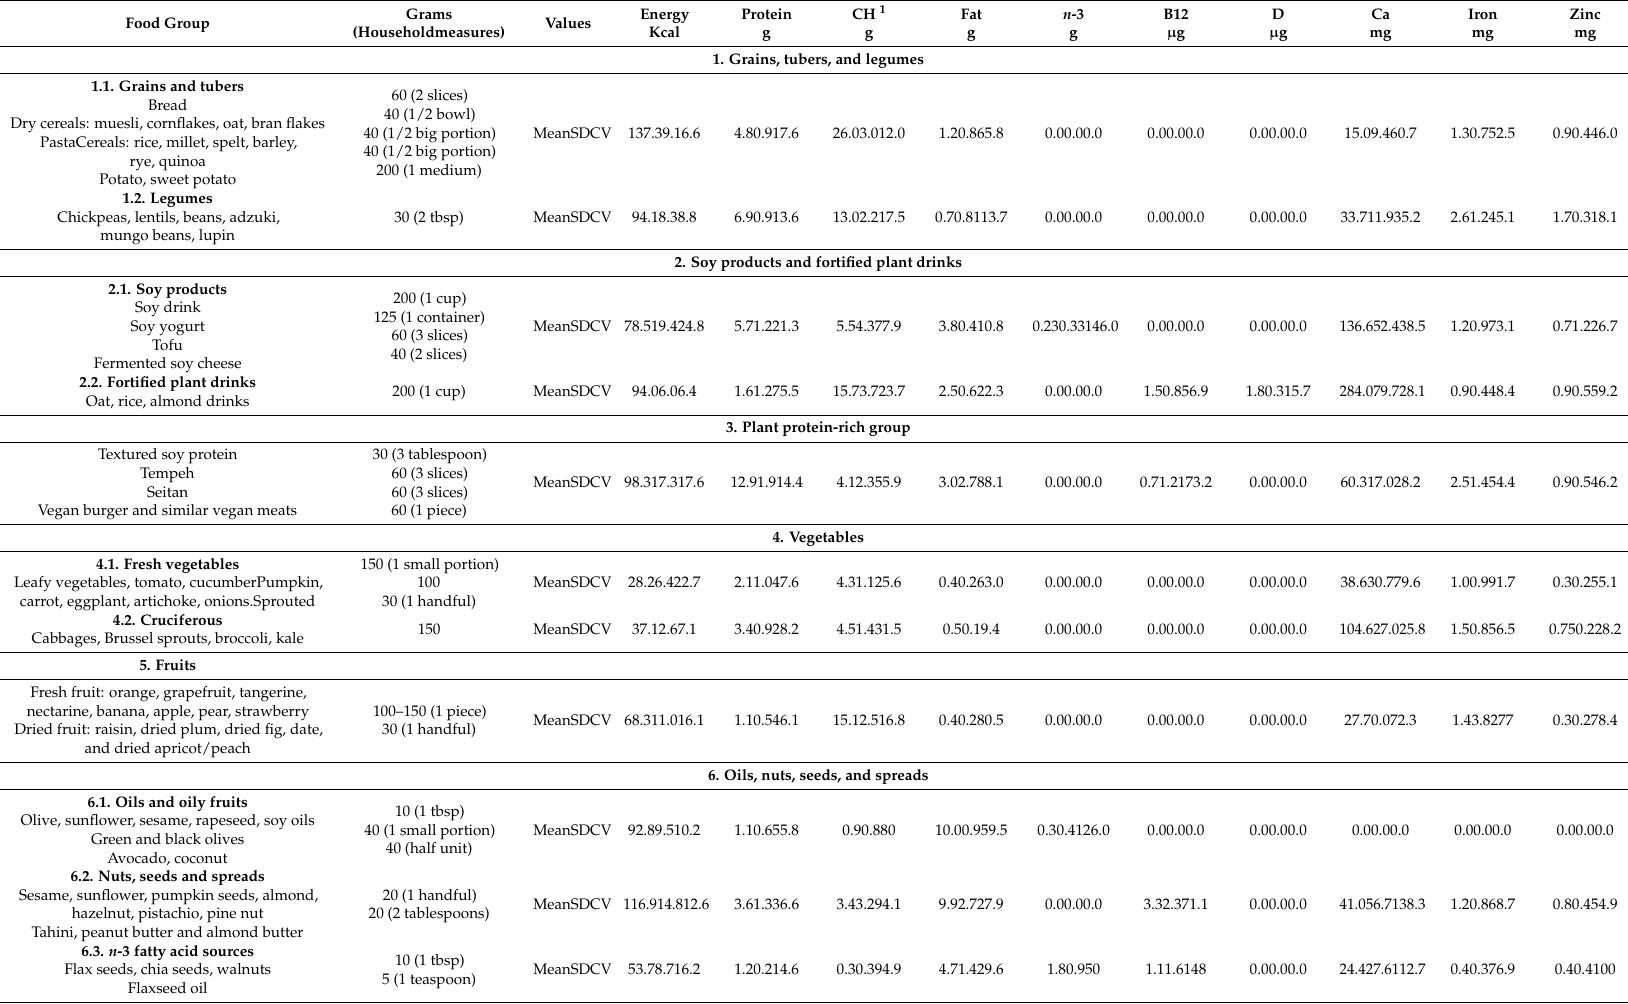
Table 1. Food groups and subgroups with the portion exchanges proposed for the more representative foods of each list expressed in grams and in household measures with the mean energy, macronutrients, and selected micronutrients content per group or subgroup. Data of SD, CV are